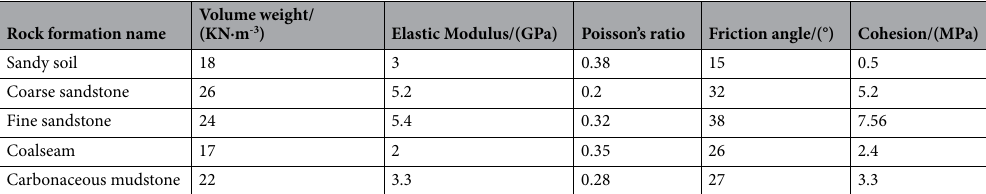
Table 1. Physical and mechanical parameters of coal and rock